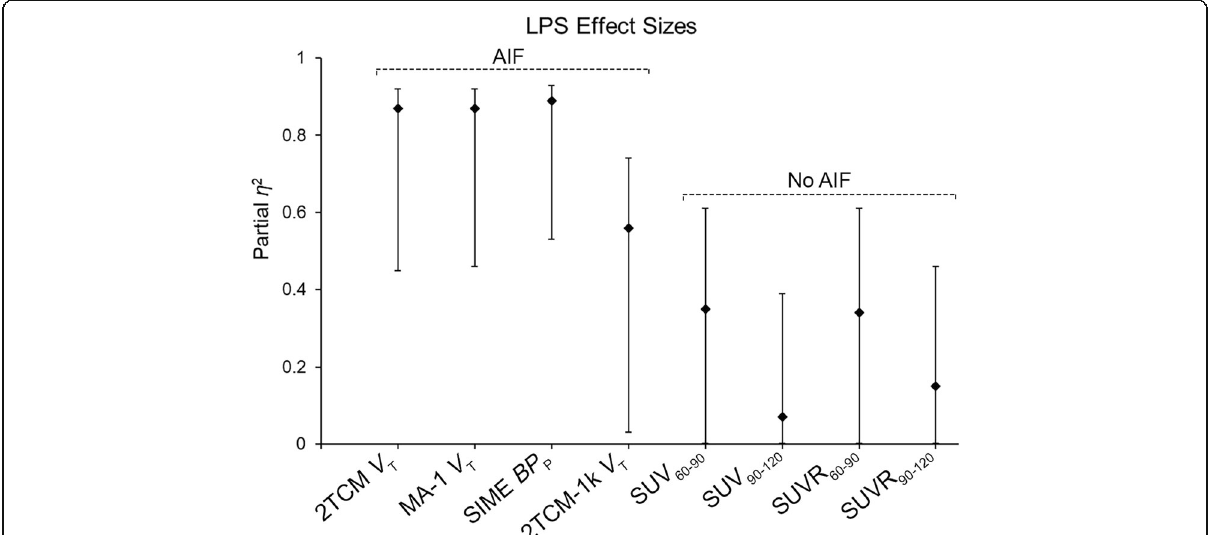
Fig. 1 LPS effect sizes (partial η 2 ) and 95% confidence intervals for each analytic approach are